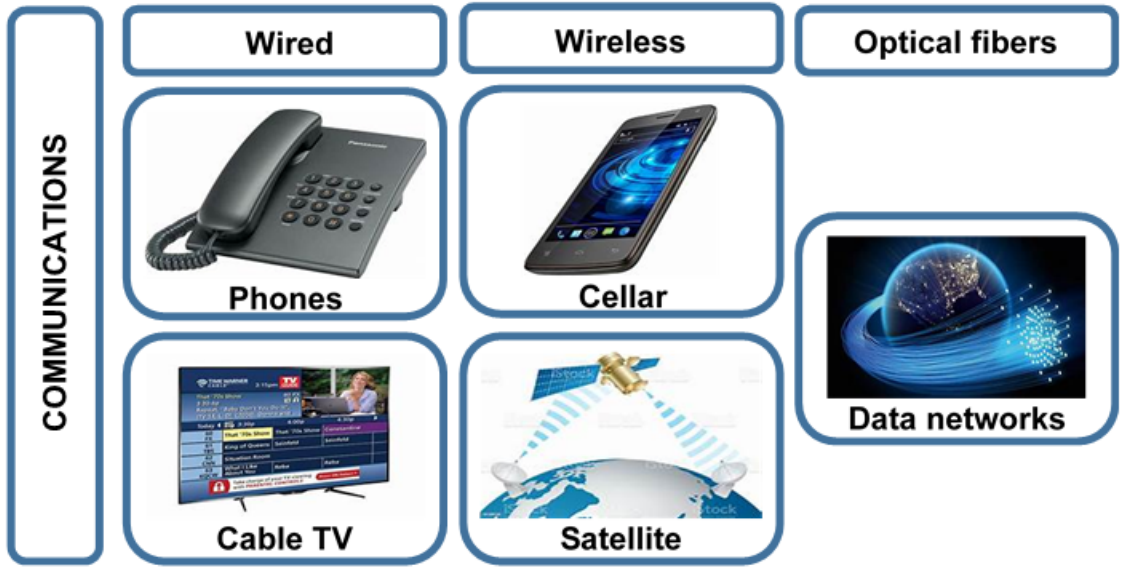
Figure 13. Communication networks topics.